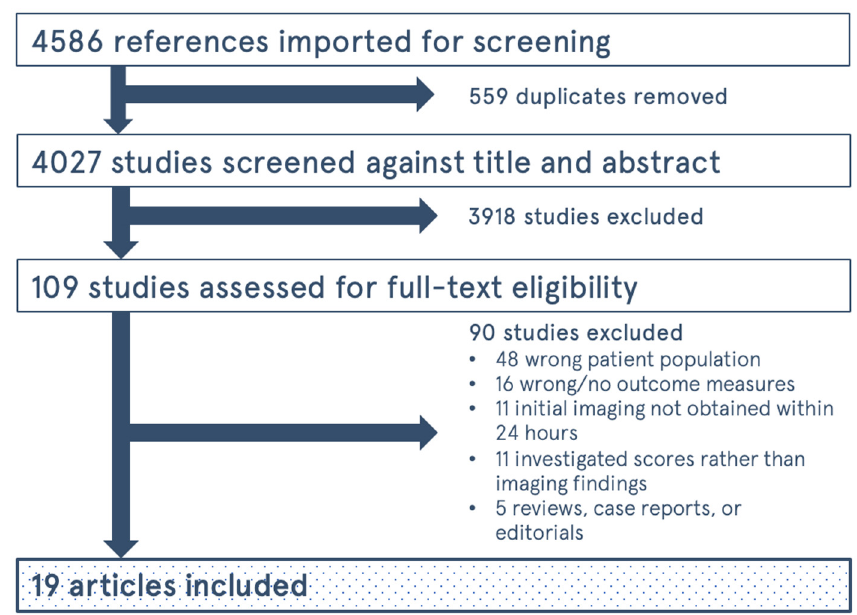
Figure 1. Flow Diagram for study selection process. Table 1. Study